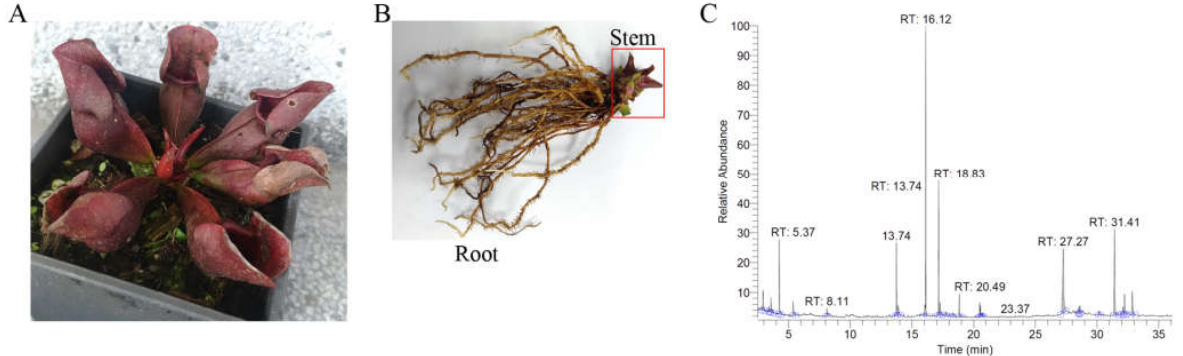
plant with cone-shaped leaves, used for obtaining supplemental nutrients. ( B ) Stem of S. purpurea .